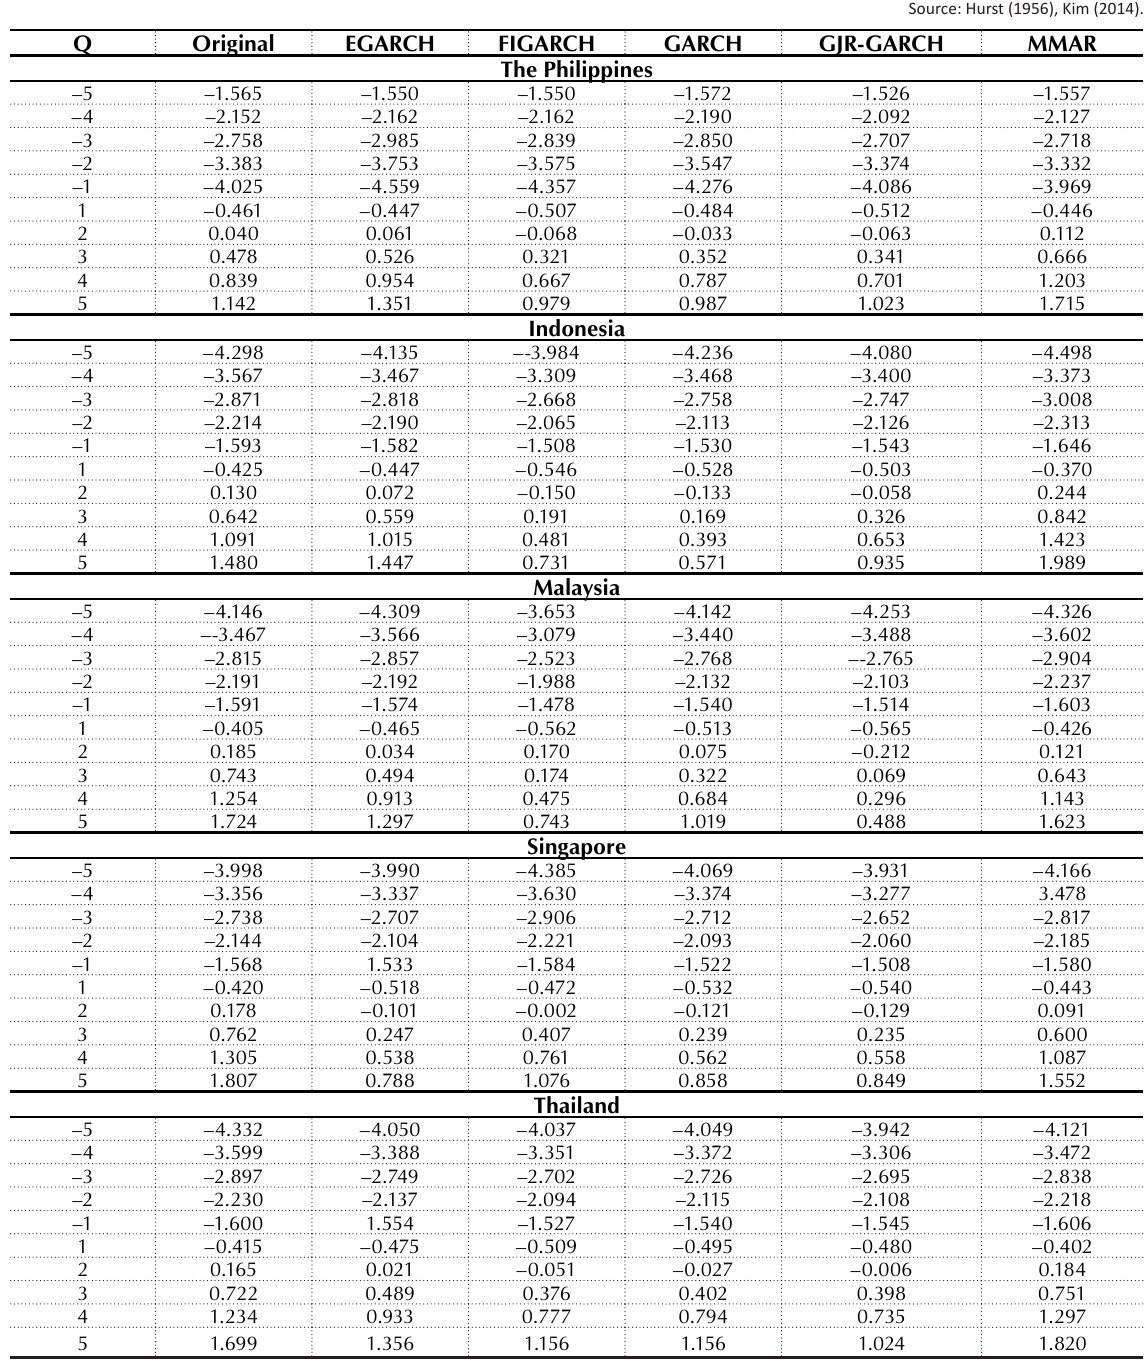
Table 8. Standard deviation from difference between original and simulated